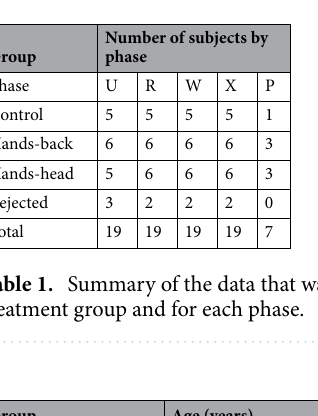
Group Age (years) Height (cm)